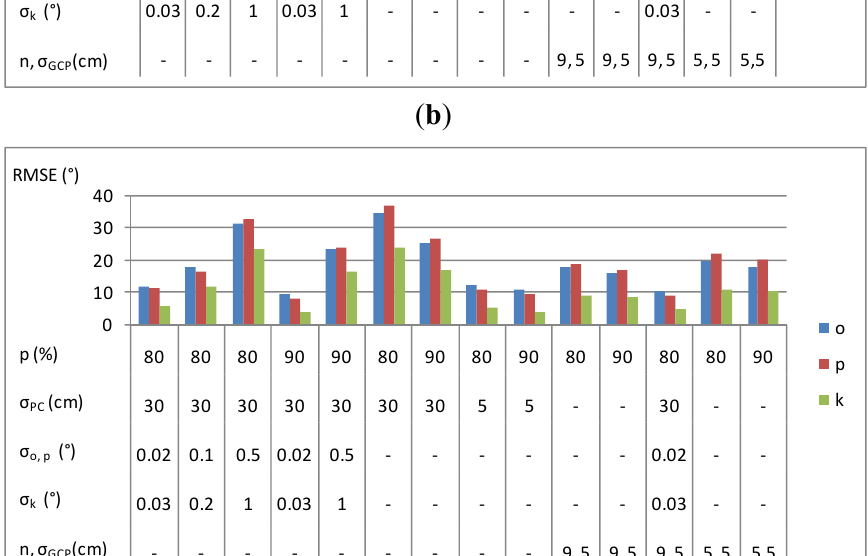
Figure 4. Statistics on simulations: standard deviations of ( a ) point determination, ( b ) positions of perspective centers and ( c ) image rotations. Settings that were used in simulations are shown below bars (p (%): forward overlap percentage; σ standard deviations for perspective center, rotation and GCP observations; observations marked with ‘-’ were not included in simulation; o, p, k: ω , φ , κ ; n: number of